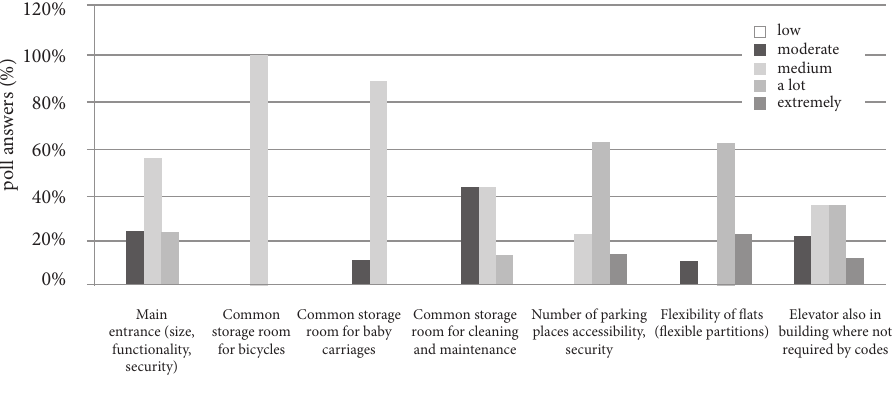
Fig. 2. Relative importance of criteria within “Functional characteristics of apartment building” element from the area “Architecture” as determined by the poll